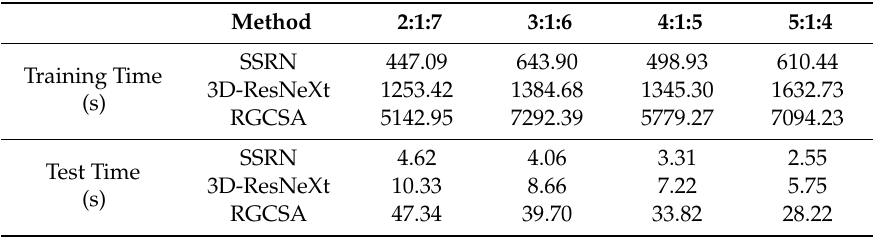
Table 17. Training time and test time for di ff erent networks in the KSC